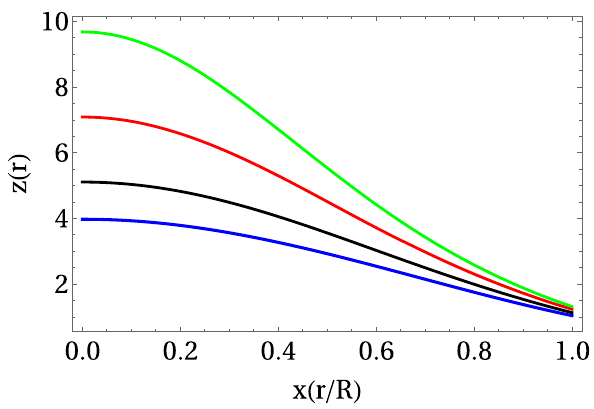
Fig. 15 z ( r ) for Model II for compact factors: 0.38 (blue line), 0.39 (black line), 0.40 (red line) and 0.407 (green line)